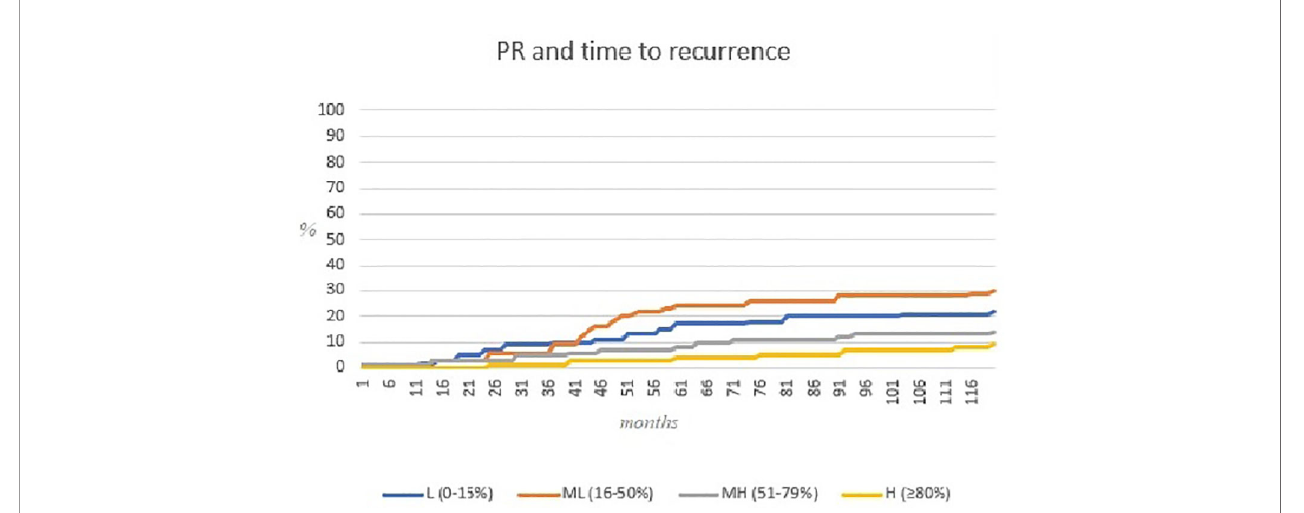
FIGURE 2 | Kaplan – Meier curve representing relation between PR expression and time to